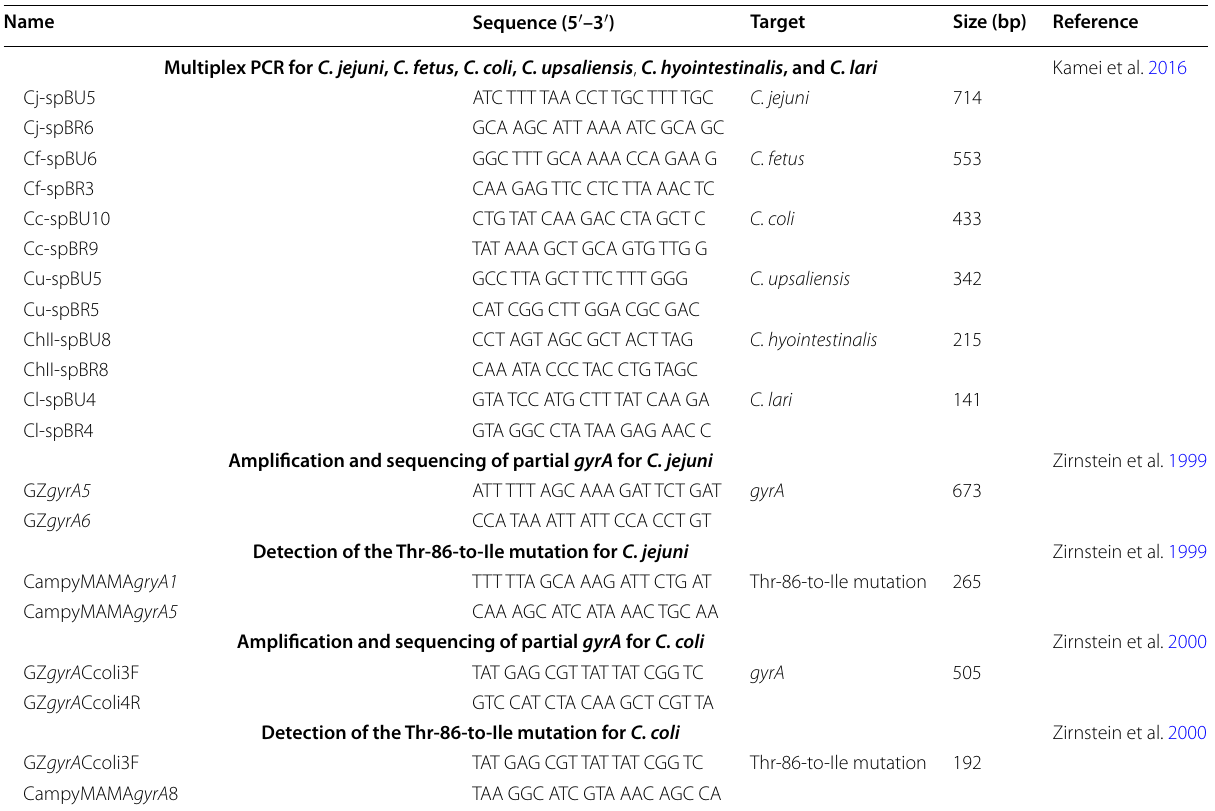
Table 3 List of primers used in this study